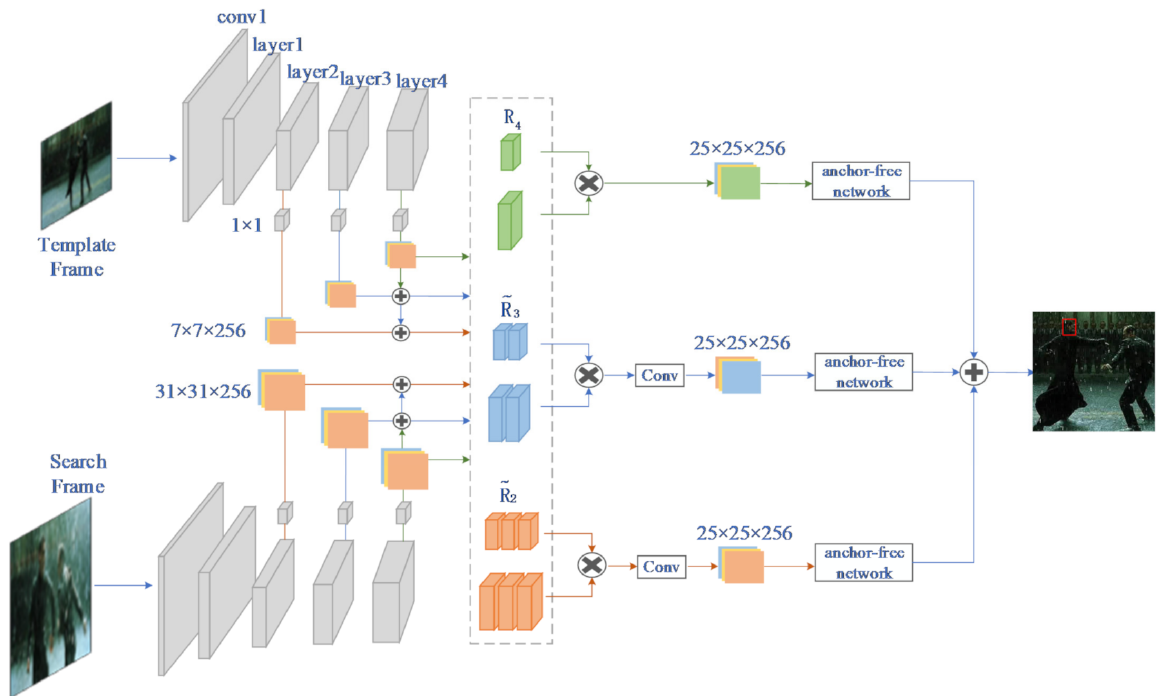
Figure 1. The architecture of our AFSN (Anchor-Free Siamese